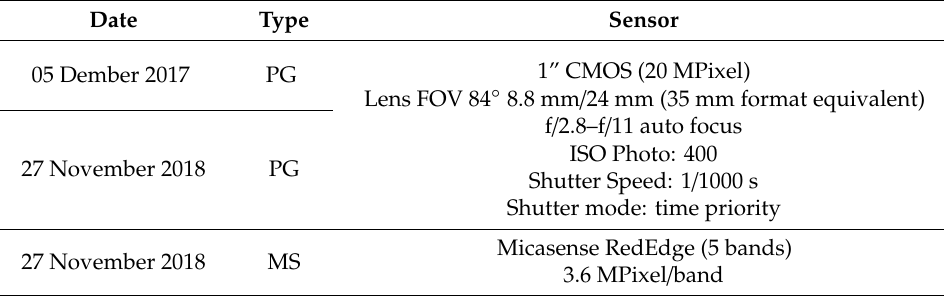
Table 1. Unmanned aerial vehicle (UAV) flights